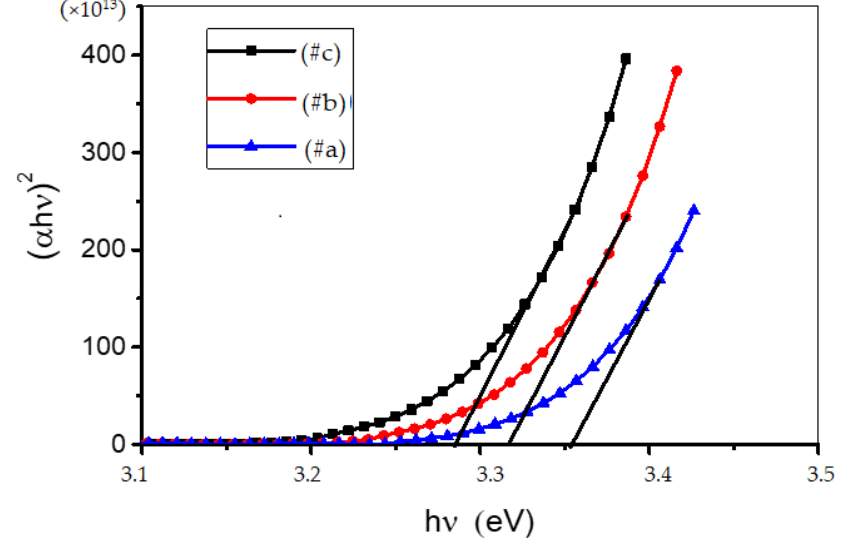
Table 4. Determination of E g band-gap values from the plot of (α h ν) vs. h ν  and comparison to literature data.